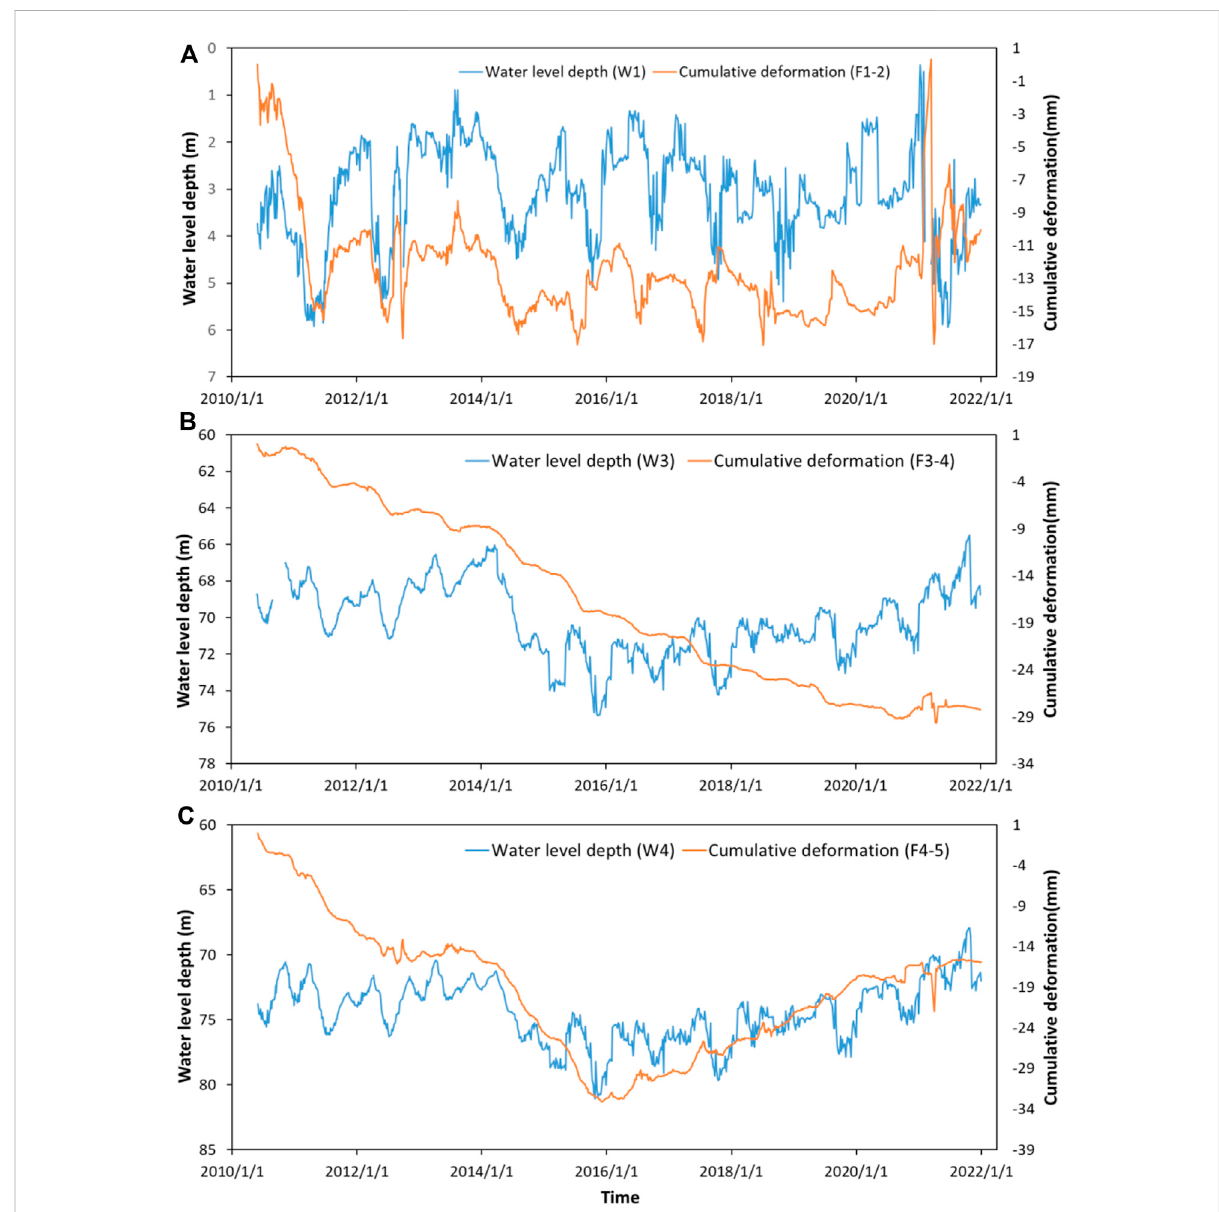
FIGURE 8 Hydrographs and cumulative deformation: (A) well W 1 and compression layer F 1-2 ; (B) well W 3 and compression layer F 3-4 ; (C) well W 4 and compression layer F 4-5 . The negative sign in the cumulative deformation indicates